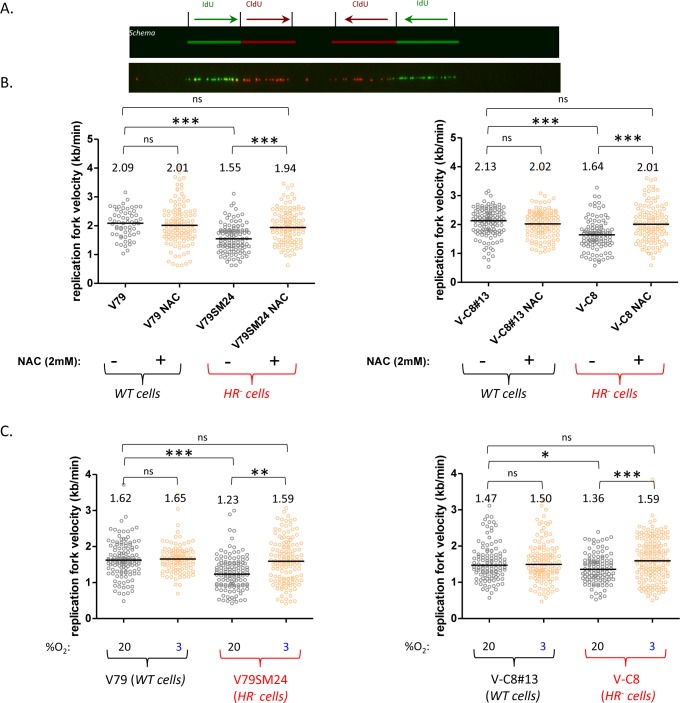
Impact of NAC or low O2 levels on the genome-wide replication fork speed.A/ Examples of combed DNA fibers with replication tracts: IdU (green), CldU (red) and the scheme of the experiment (upper panels). B/ RF speed distribution in V79 cells and derivatives (left) and V-C8 cells and derivatives (right) after exposure to NAC (3 mM). C/ RF speed distribution in V79 cells and derivatives (left) and V-C8 cells and derivatives (right) that were maintained at 20% versus 3% O2. The median and p-values are indicated in the histogram (*P < 0.05; **P < 0.01; ***P < 0.001). The median values are represented as horizontal black lines. ns: not significant. Approximately 100–120 fibers were scored per condition.